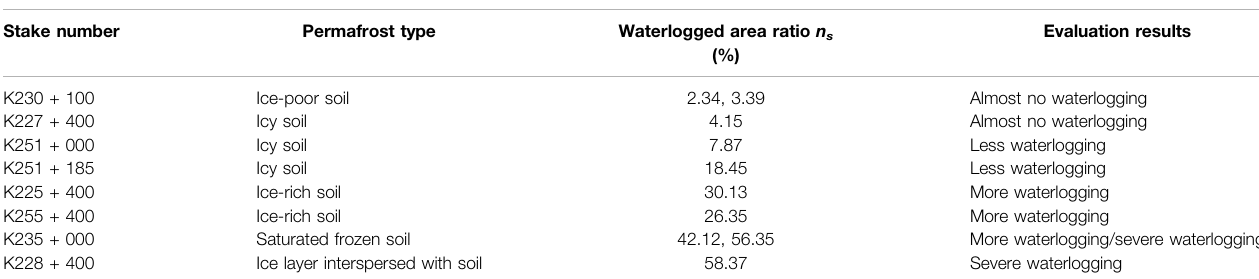
TABLE 2 | Waterlogged area ratio of PWs near typical road